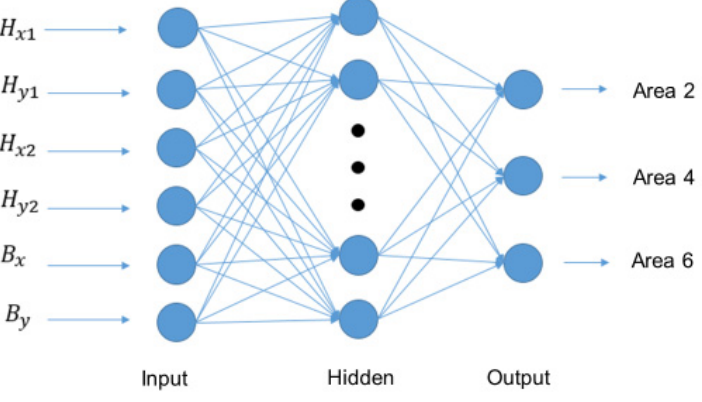
Figure 14. Network architecture of data set 2.